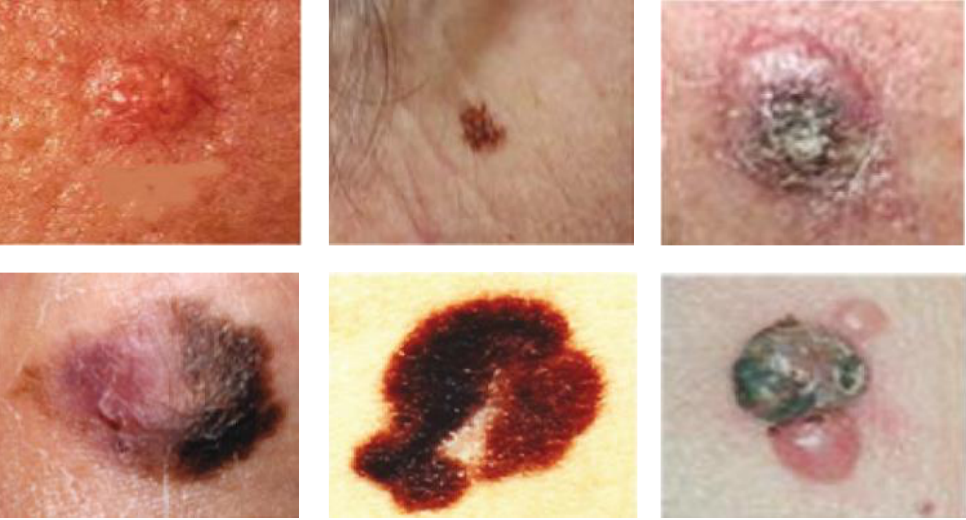
Figure 6. A sample of skin lesions of melanoma from the used